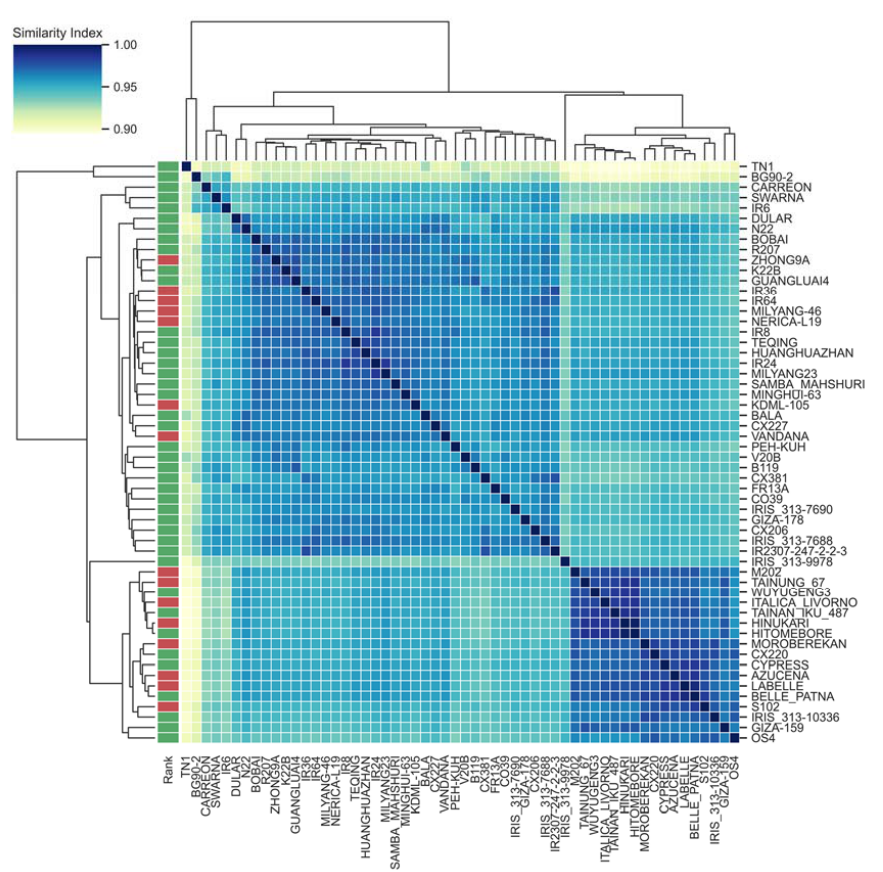
Figure 2. PAV-based pairwise relationships among the tested rice accessions *. * The left column indicates the heat stress response of the different rice cultivars. Green and red represent the heat- tolerant and -susceptible cultivars, respectively.